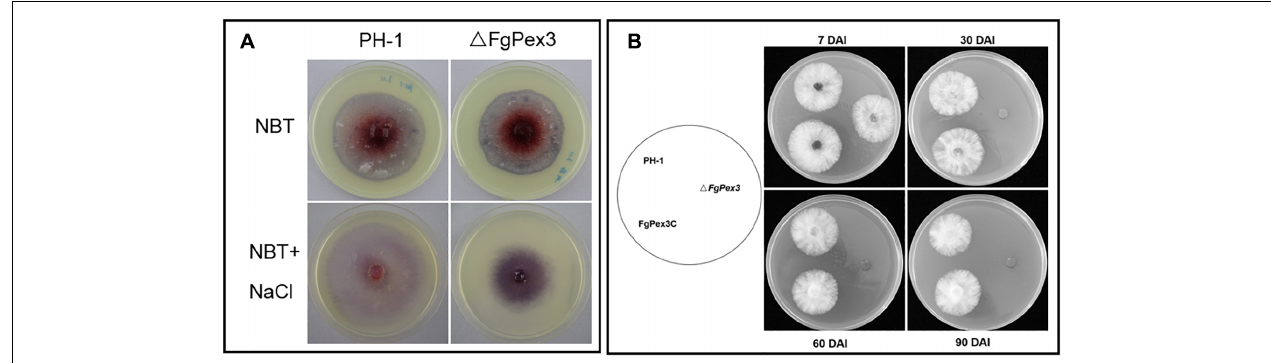
FIGURE 8 | Reduced ability of (cid:49) FgPex3 to scavenge reactive oxygen species (ROS) survival assay. (A) Tetranitroblue tetrazolium chloride (NBT) staining for ROS accumulation in cultures of (cid:49) FgPex3 and the wild-type. In plates at the bottom 0.6 M NaCl was added to promote ROS production. The dark blue color of the colony indicated ROS accumulation. (B) Strains PH-1, (cid:49) FgPex3 , FgPex3C were inoculated onto CM plates and incubated for 7–90 days. Mycelial plugs from the cultures were transferred to fresh CM agar plates, and the viability of the culture was observed. DAI, days after